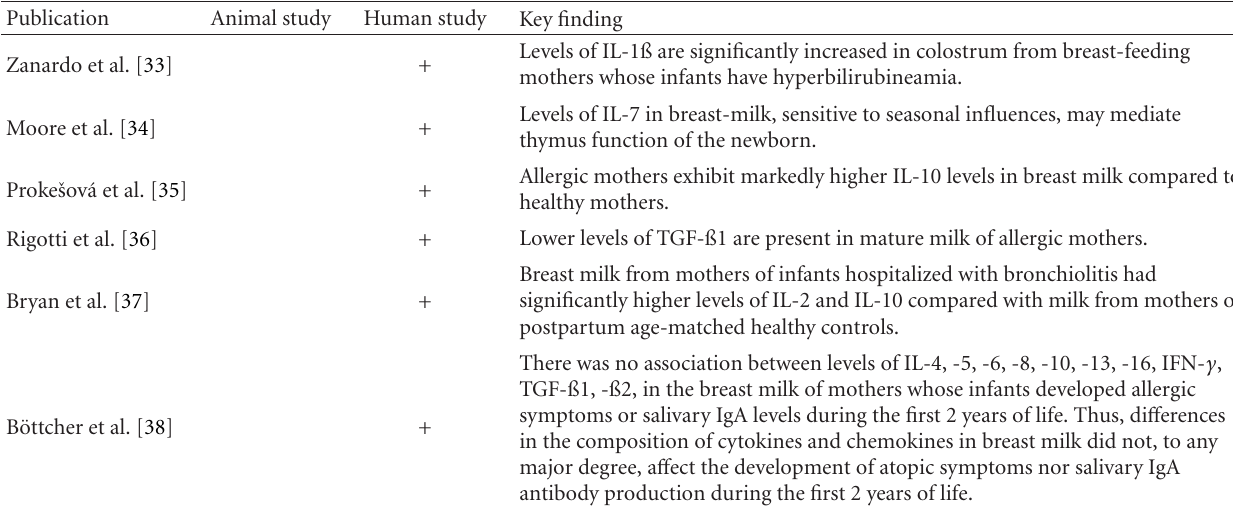
Table 2: Key findings on immune alteration in breast milk, identified upon search for the topic “pathological e ff ects of cytokines in the breast milk on the